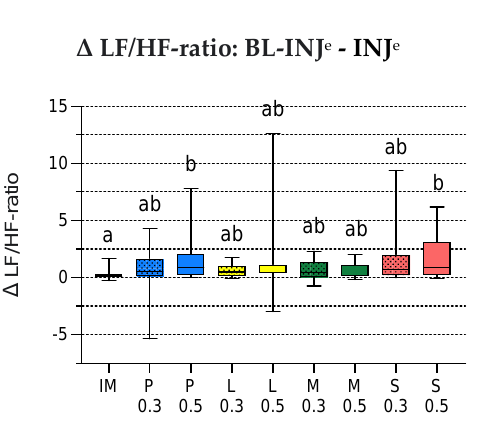
Figure 5. ( A – G ) Difference ( ∆ ) in respiratory rate, mean arterial blood pressure, heart rate, RR- Interval, SDHR, SDRR and LF/HF-ratio between baseline and injection in the experimental groups. Bar diagrams of ( A ) mean difference in respiratory rate [breaths minute −1 ] between baseline and maximum respiratory rate during injection, ( B ) mean difference in mean arterial blood pressure (MAP) [mmHg] between baseline and maximum MAP during injection, ( C ) mean difference in heart rate [beats minute −1 ] between baseline and during injection, ( D ) mean difference in RR-Interval [ms] between baseline and during injection with the mean at the top of the bar and the whiskers as standard deviation. Boxplots of ( E ) difference in standard deviation of heart rate (SDHR) [beats minute −1 ] between baseline and during injection, ( F ) difference in standard deviation of RR-Interval (SDRR) [ms] between baseline and during injection and ( G ) difference in low frequency/high frequency (LF/HF) ratio between baseline and during injection. The boxes representing the first and third quartile and the whiskers ranging from minimum to maximum. The median is indicated by the band inside the box. Different letters (a, b, c) show significant differences between the experimental groups ( p < 0.05). The superscript “ e” differentiates time periods/episodes( “ e ” ) from time points (MAP and respiratory rate). The red asterisk (*) marks an increase above 10% from baseline.